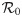
Level sets as a function of the working days X obtained with an FPSP of period 7 days.(Left) Changing R0 in [1, 4.4]. (Centre) Changing quarantine effectiveness q in [0, 1]. (Right) Changing compensatory factor d in [0, 1].